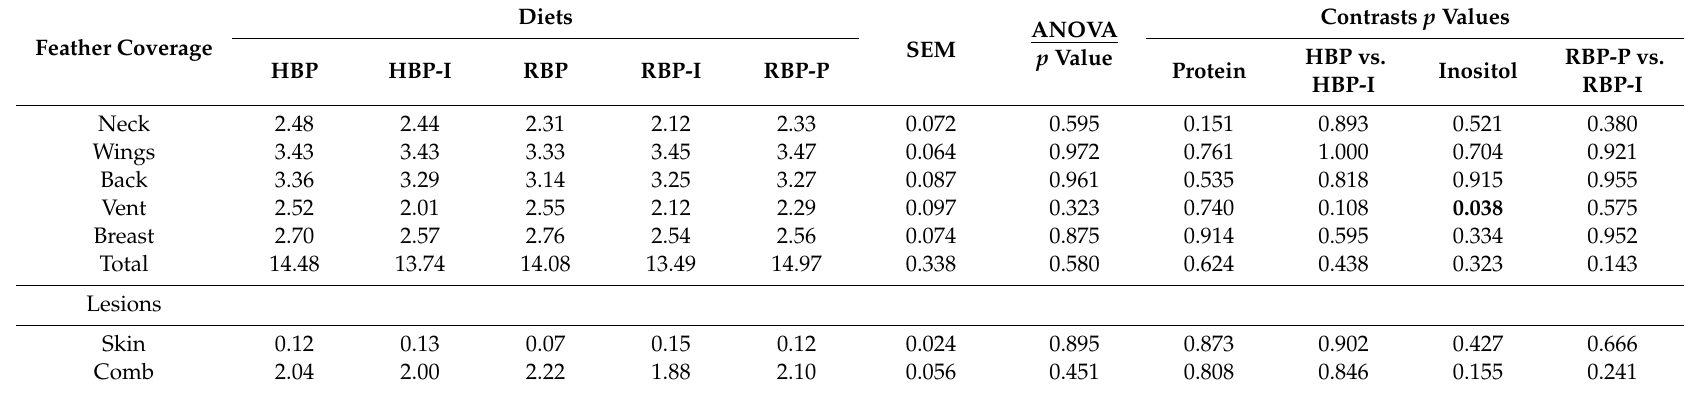
Table 4. E ff ect of dietary protein, inositol and phytase on laying hen feather coverage and skin and comb lesions at 59 weeks of age.